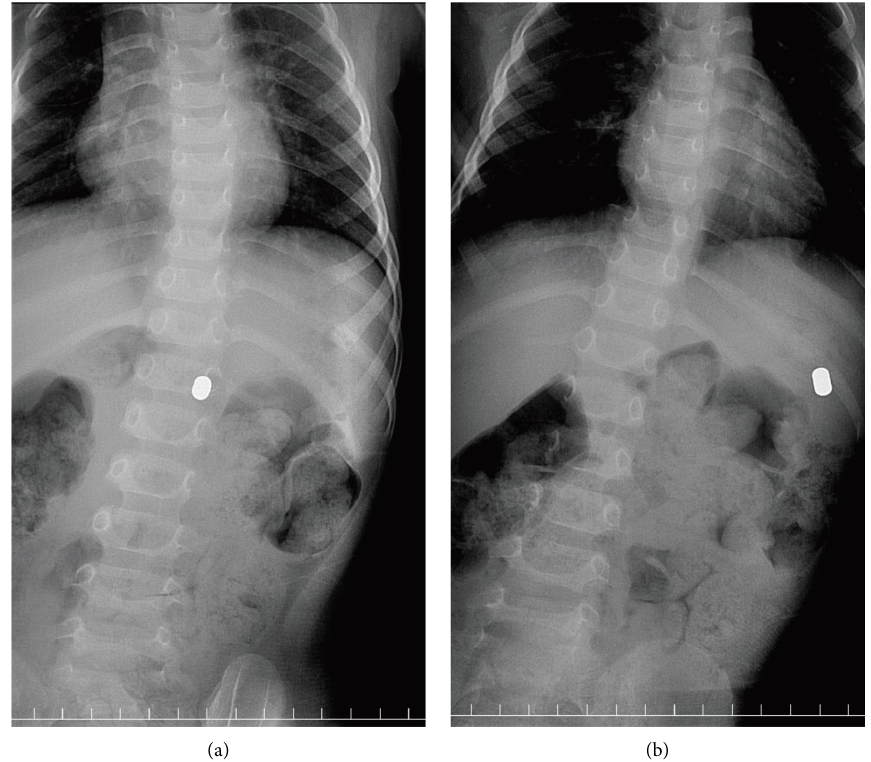
Figure 2: Abdominal fuoroscopy fndings. (a) Te patient was placed in right lateral decubitus position for 3min and slowly returned to supine position. Abdominal fuoroscopy indicated the magnets were migrating near the middle of the spine. (b) When she was placed in left lateral decubitus position for 3 min and slowly returned to supine position, fuoroscopy revealed that the magnets migrated to the outermost part of her left upper